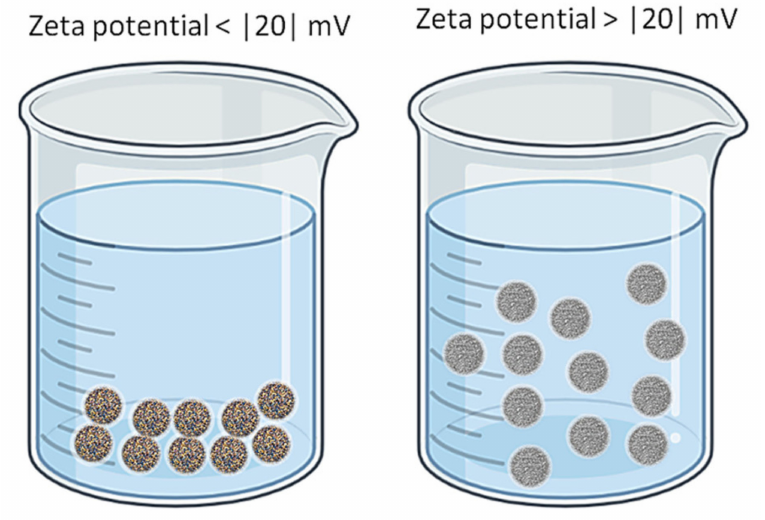
Figure 7. The influence of zeta potential on NP